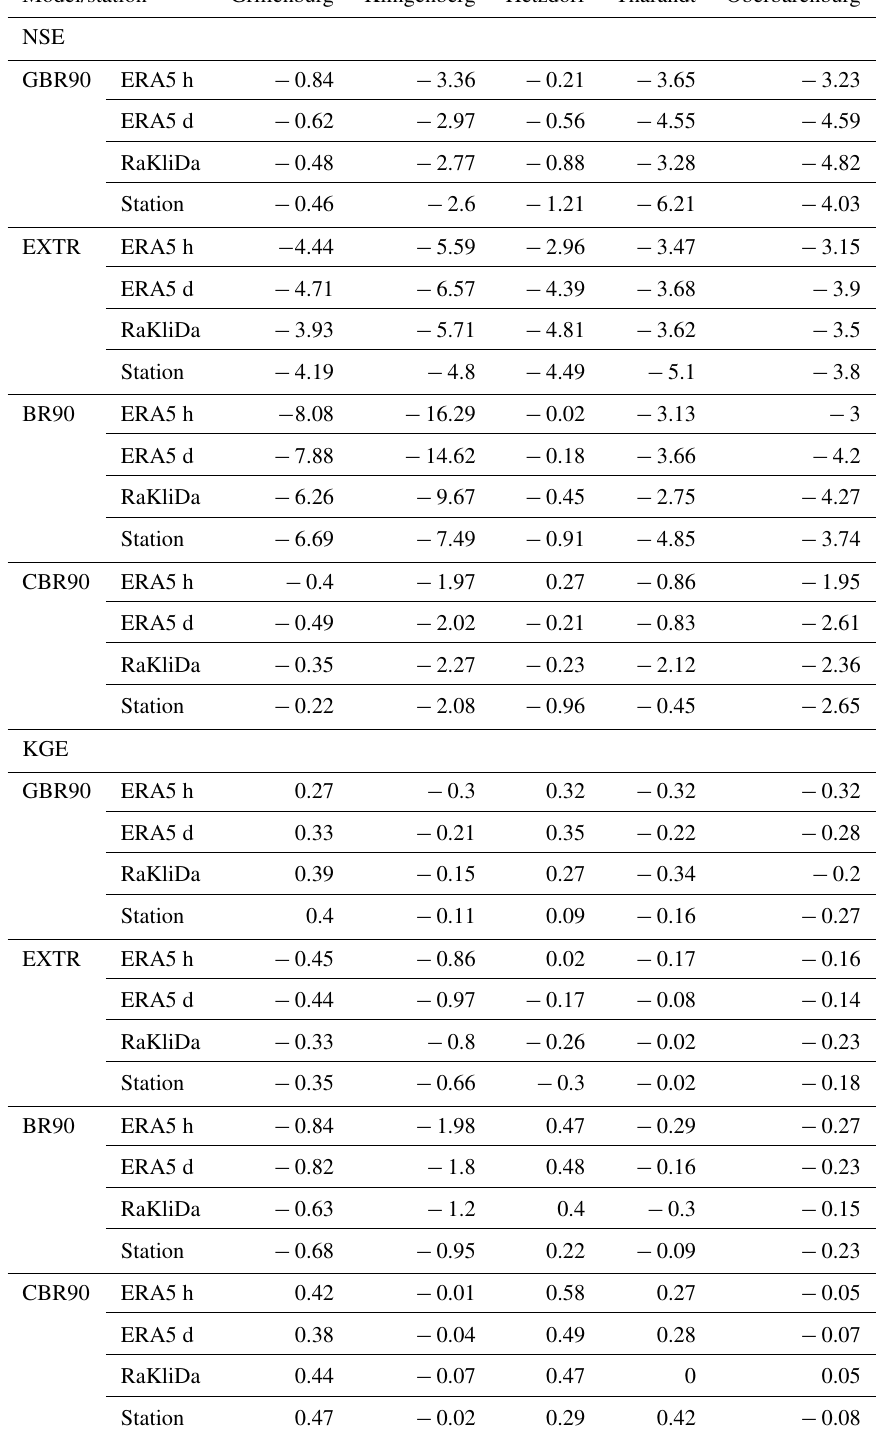
Table E6. Monthly evaporation skill scores for the winter period. Model/station Grillenburg